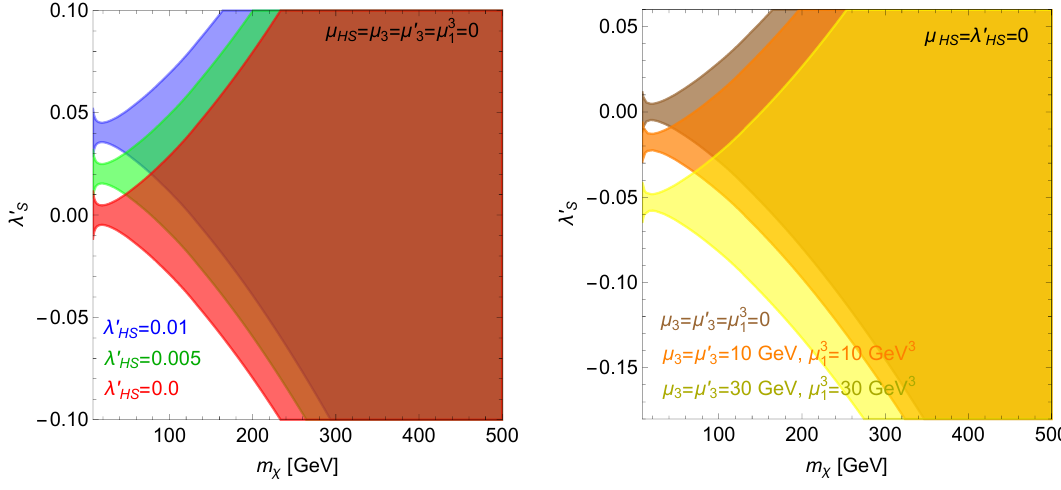
Figure 2 . Coloured regions are what is allowed by direct-detection bounds from XENON1T for sin (cid:18) = 0 : 1, regardless of the relic-density contribution of the DM candidate. In the symmetry- breaking potential all terms with odd powers of the singlet have been set to zero in the left panel, and in the right panel all doublet-singlet mixing terms have been set to zero. In both panels w = 250 GeV and m 2 = 200